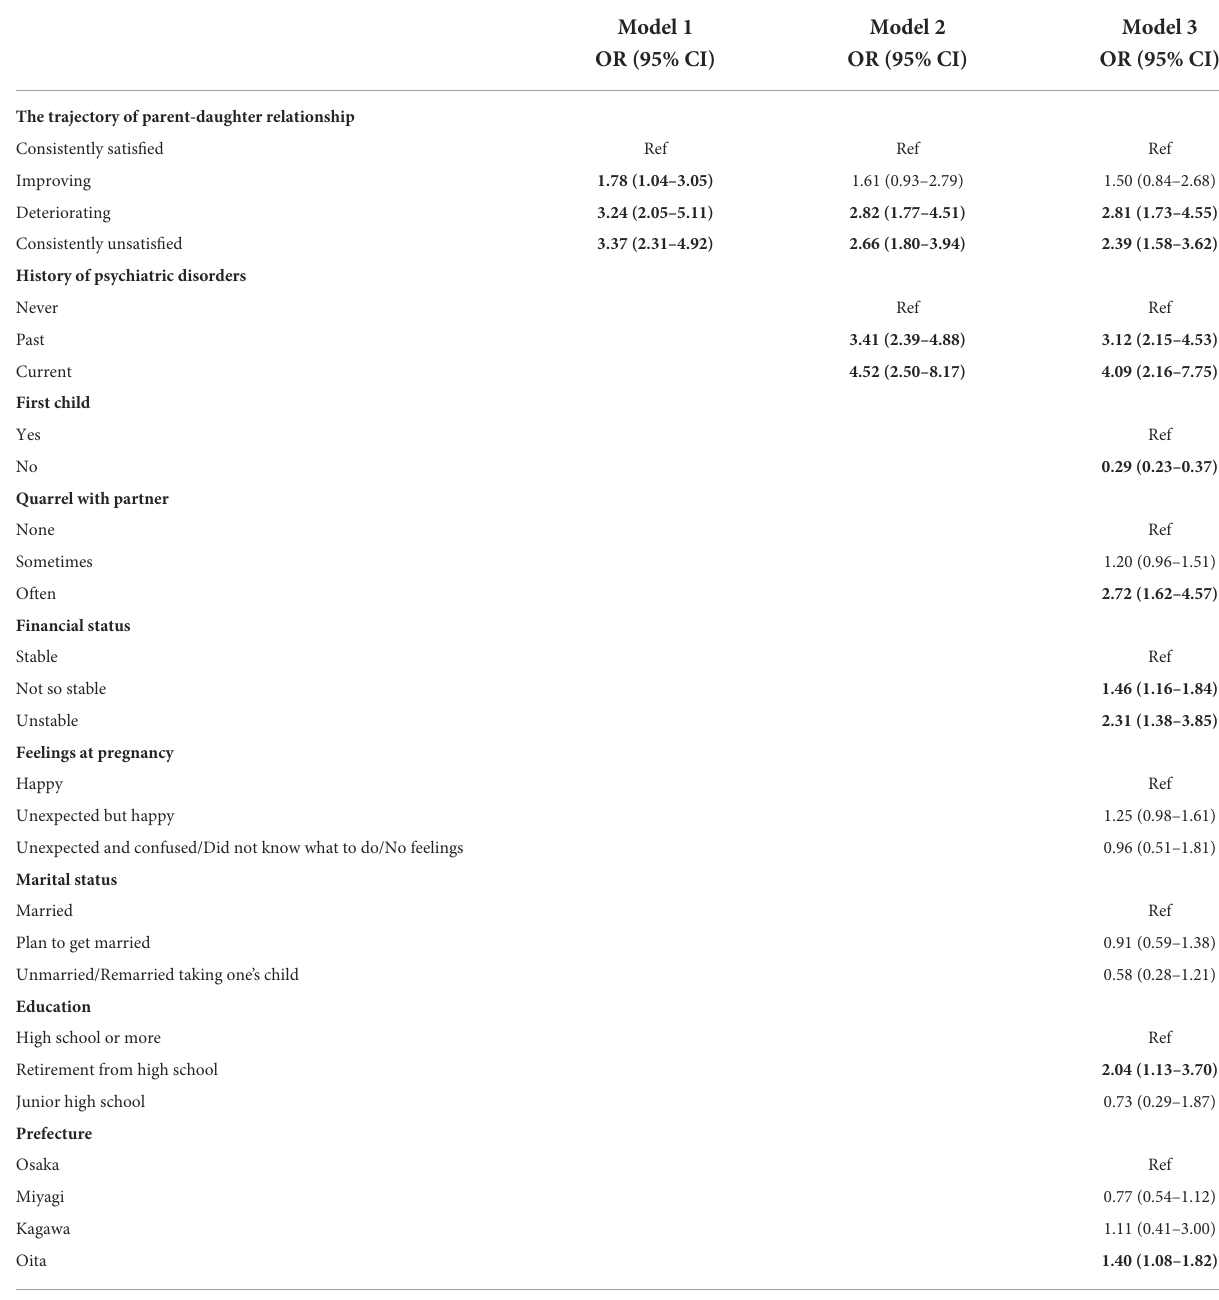
TABLE 2 Adjusted odds ratio with 95% confidence intervals for the association of the trajectory of parent-daughter relationship and postpartum depression in Japanese women.